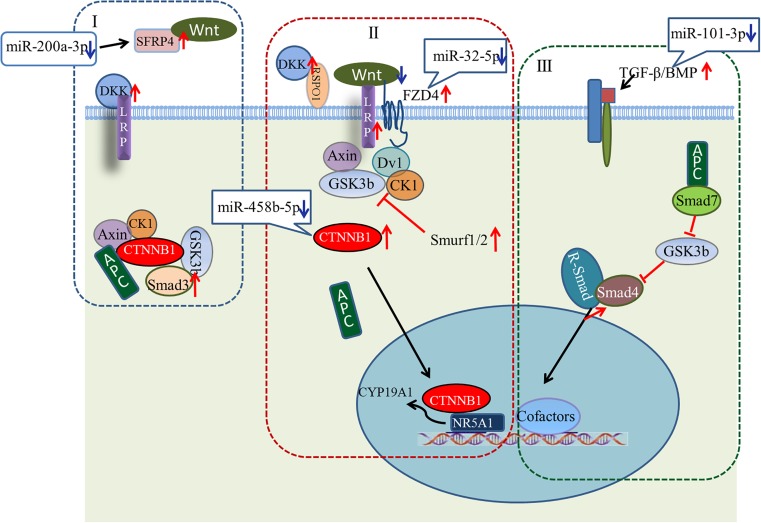
Model showing possible mechanism for regulation of ovarian development by four key miRNA/gene pairs. (I) Wnt/CTNNB1 signaling pathway in resting state; (II) Wnt/CTNNB1 signaling pathway is activated by the binding of a WNT to the FZD and LRP co-receptors; (III) TGF-beta pathway.